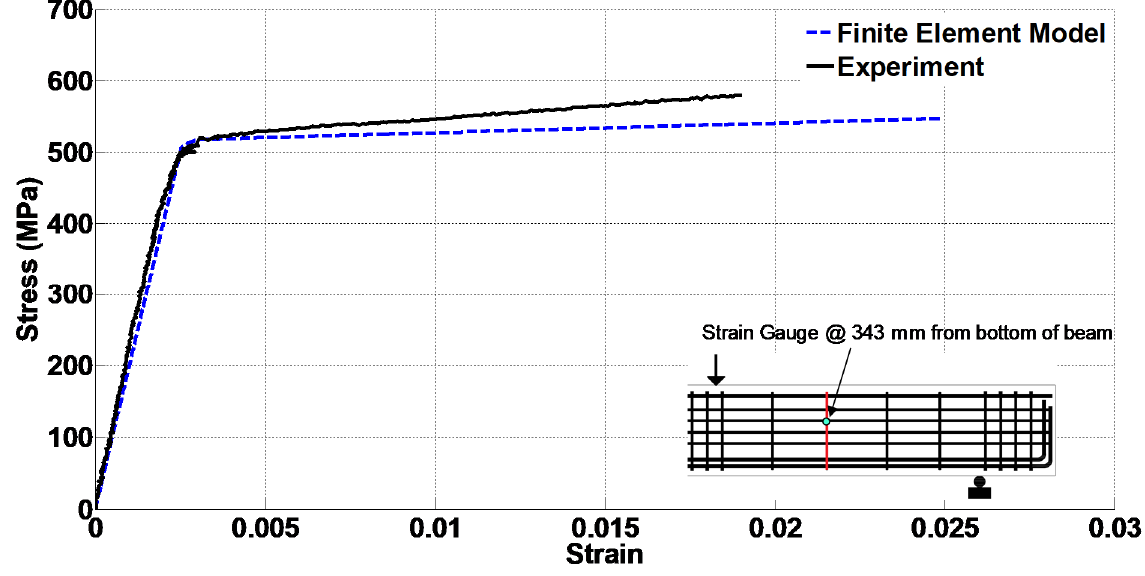
Figure 13. Comparison of the experimental and numerical stress–strain diagrams in the stirrup close to the middle of the span.